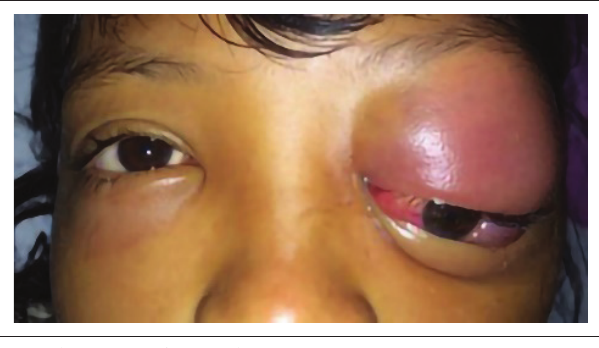
FIGURE 1: There was non-axial proptosis with inferior displacement of the left eye. The eyelid was oedematous and hyperaemic.